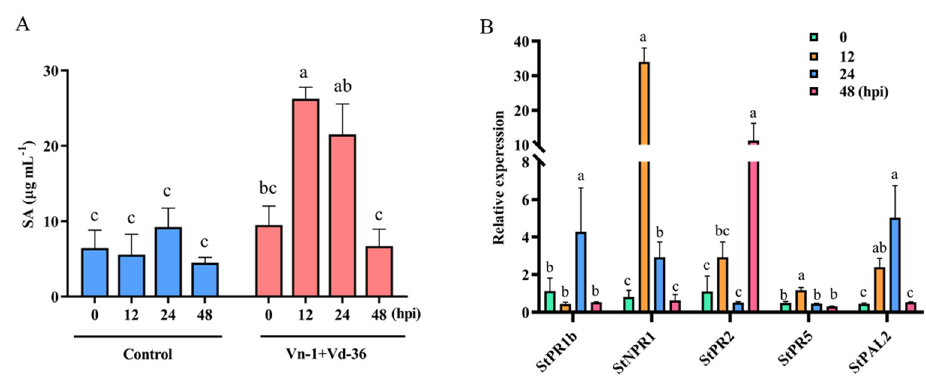
Figure 4. Vn-1 triggers defense PRs genes to improve jasmonic acid (JA) production in potatoes: ( A ) salicylic acid (SA) content at different times. Three leaves were collected from each plant, and each treatment consisted of three plants and was repeated three times. Values are mean ± SE ( n = 3); sterile water was used as control; ( B ) the relative expression of related defense genes in SA signalling pathway was measured by real-time polymerase chain reaction; letters above bars indicate the significant differences between groups (Tukey’s multiple comparisons, p < 0.05). Three biological replicates were used.